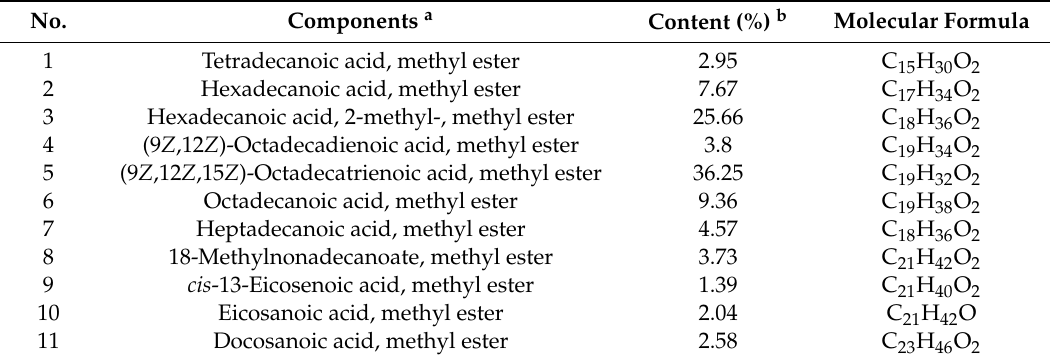
Figure 3. GC chromatograms of solution of samples. Peaks: 1, Tetradecanoic acid, methyl ester; 2, Hexadecanoic acid, methyl ester; 3, Hexadecanoic acid, 2-methyl-, methyl ester; 4, (9 Z ,12 Z )-octadecadienoic acid, methyl ester; 5, (9 Z ,12 Z ,15 Z )-octadecatrienoic acid, methyl ester; 6, Octadecanoic acid, methyl ester; 7, Heptadecanoic acid, methyl ester; 8, 18-Methylnonadecanoate, methyl ester; 9, cis -13-Eicosenoic acid, methyl ester; 10, Eicosanoic acid, methyl ester; 11, Docosanoic acid, methyl ester. Table 4. FAs profile of the pollen oil by GC-MS